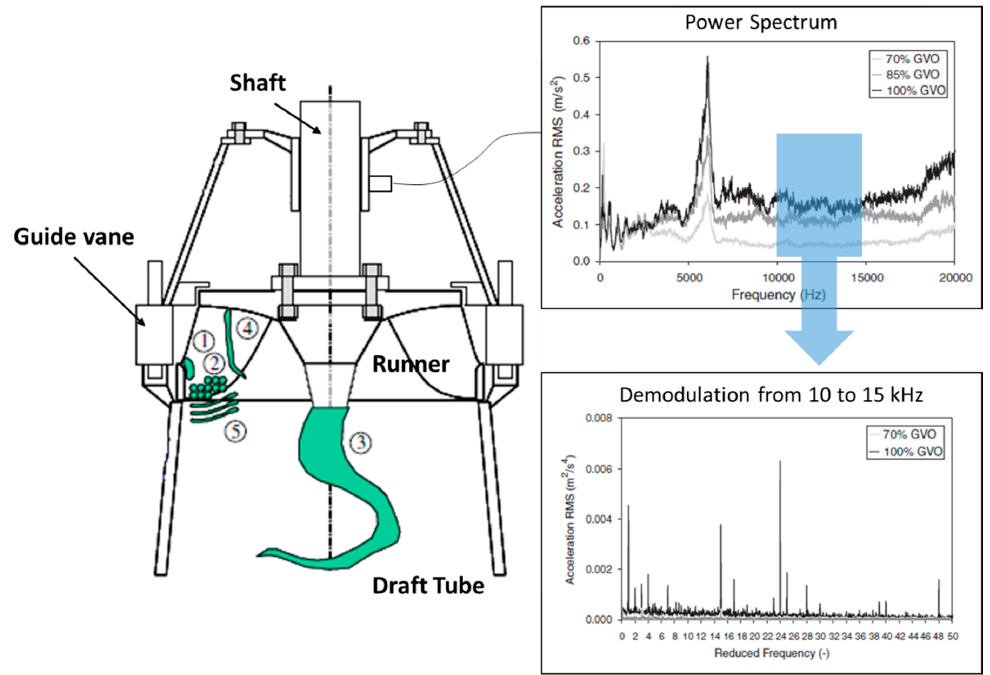
Figure 1. Sketch of a Francis turbine runner showing different types of cavitation and the current method to detect cavitation. The typical cavitation zones are highlighted in green. Adapted with permission from [9], Elsevier, 2006.